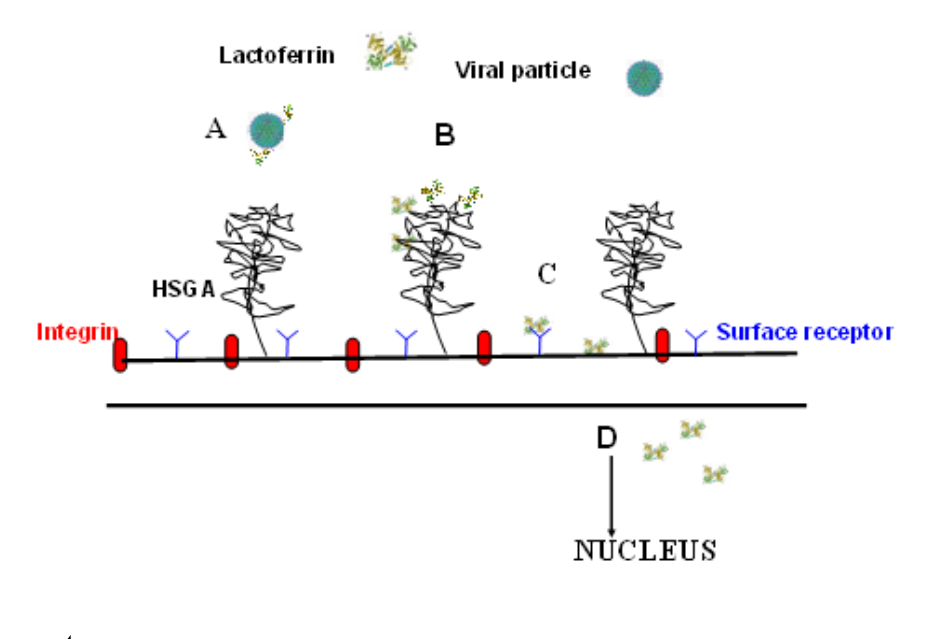
Figure 4. Different mechanisms of lactoferrin in preventing viral